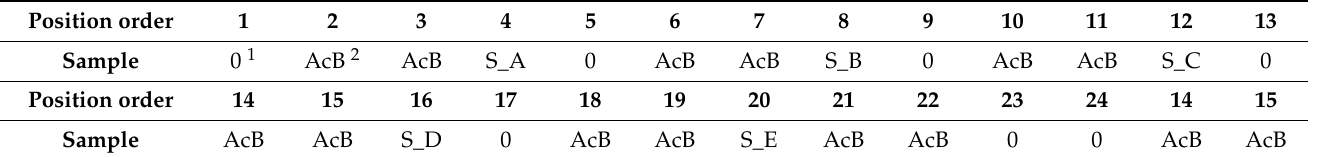
Table 3. Sequence samples of effervescent tablets for potentiometric measurements with polymerized electrode array, samples A–E are labelled S_A–S_E. The sequence was repeated 6 times (n = 6). Position